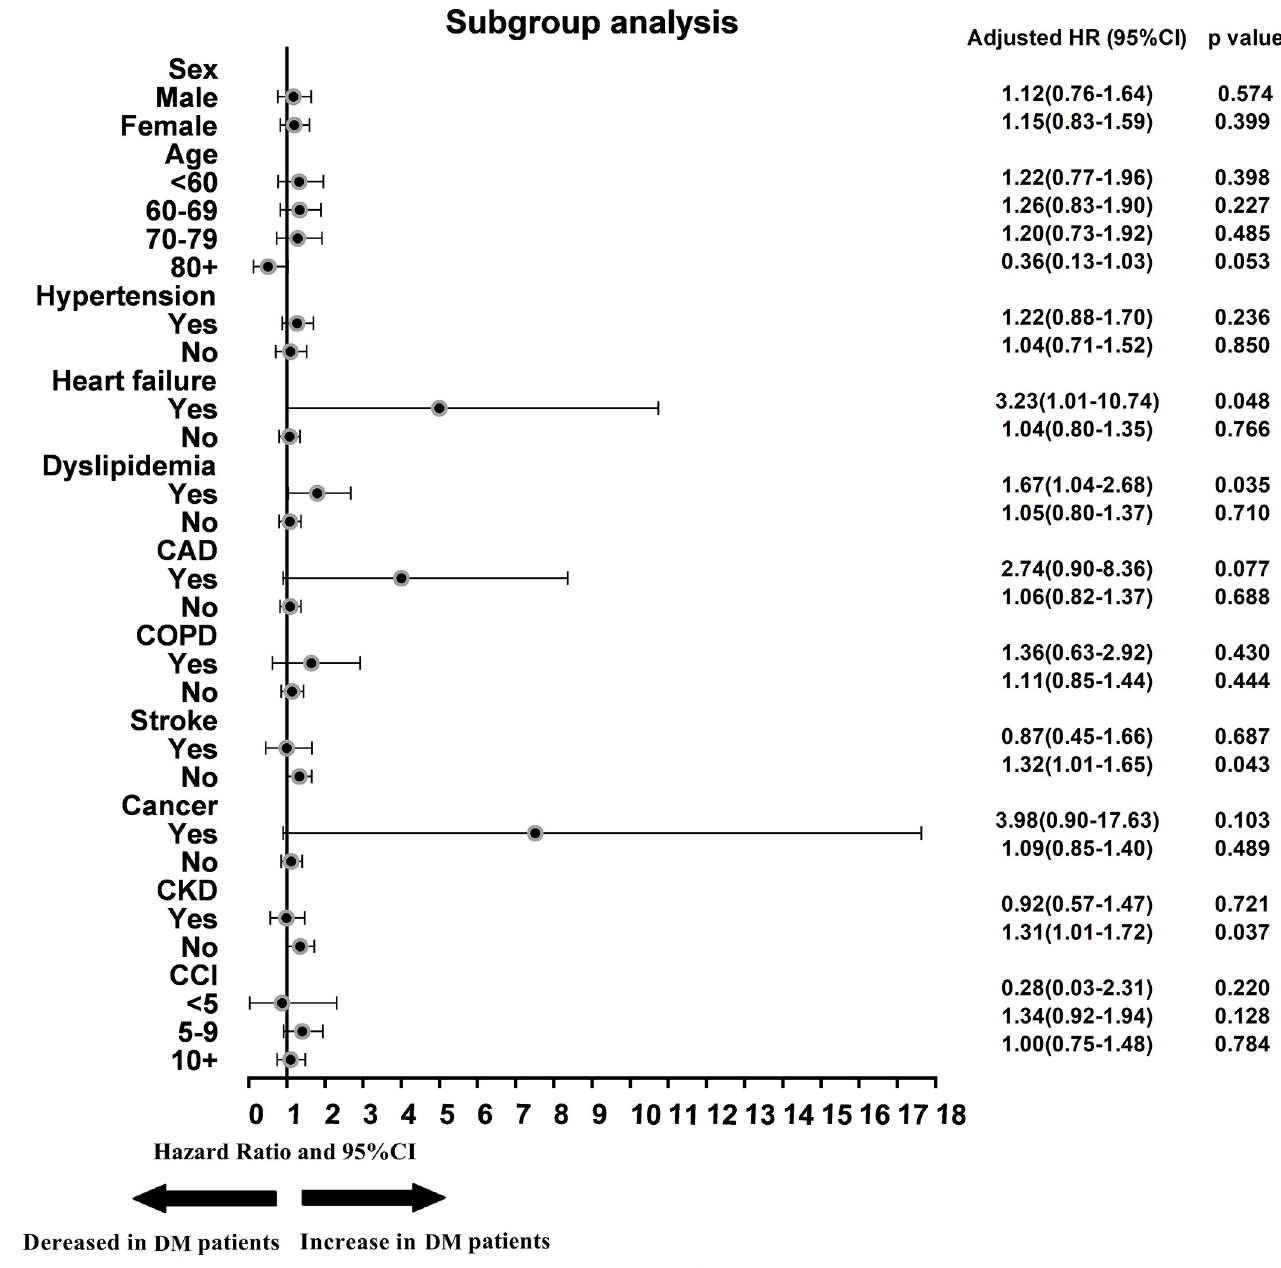
Fig 3. Risks of developing end-stage renal disease among patients with diabetes with and without atrial fibrillation, stratified according to demographic characteristics and comorbidities.